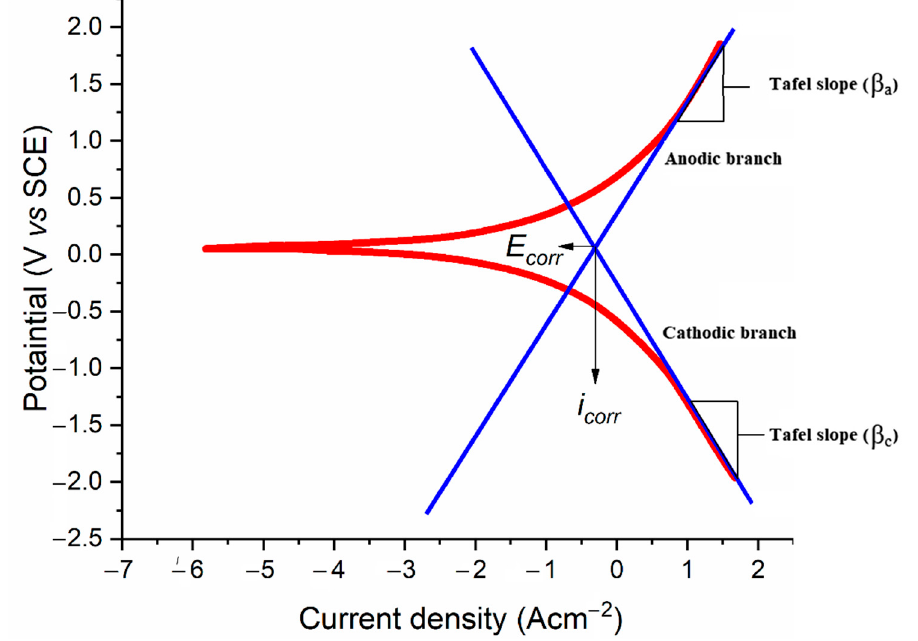
Figure 6. The Tafel slopes, corrosion potential, and corrosion current density were calculated via extrapolation.